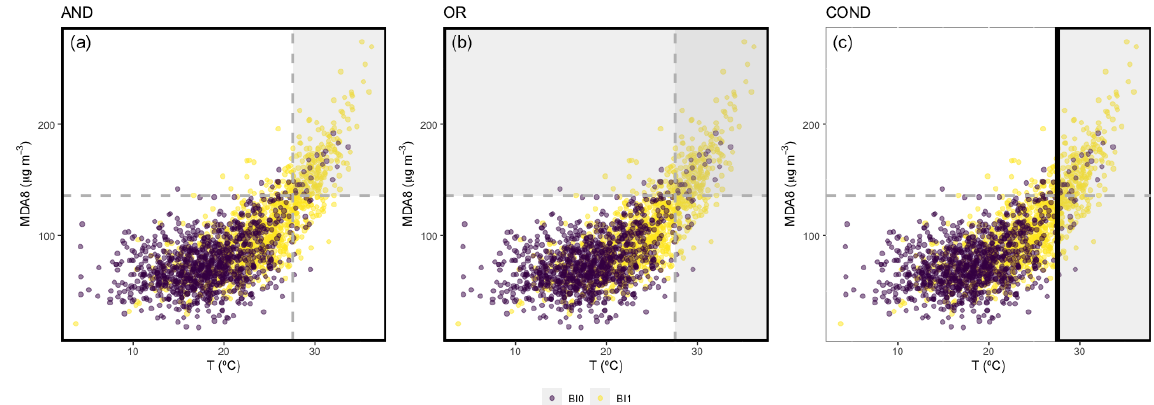
Figure 5. Illustrative example with the probability scenarios used in the study: AND (a) , OR (b) , and COND (c) . Bold black boxes identify the domain where each probability is estimated and the grey areas represent the critical regions associated with the corresponding probability. The legend colours correspond to days with blocking (BI = 1, yellow) and without blocking (BI = 0,